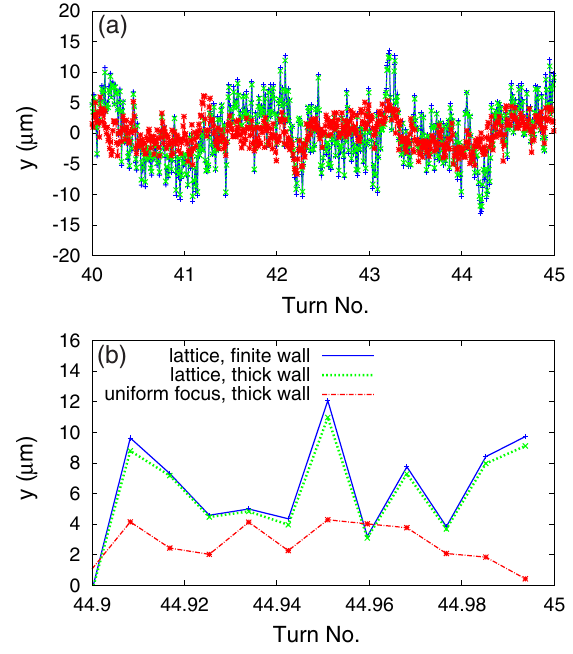
FIG. 4. (Color) (a) The dashed red line shows the jitter com- puted with the approximation of uniform focusing, and using the wake force in the high-frequency limit (case I). The dotted green line again approximates the wake function using the high- frequency limit, but uses the actual lattice functions (case II). The solid blue line shows the jitter for the actual lattice and a beam pipe with finite wall thickness (case III). (b) The horizontal scale is magnified to show the relative magnitude of the jitter in each case.